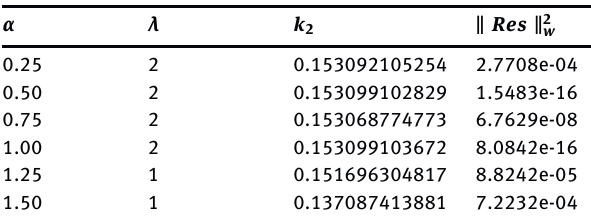
Table 16: Obtained values of k 2 by the present method for various